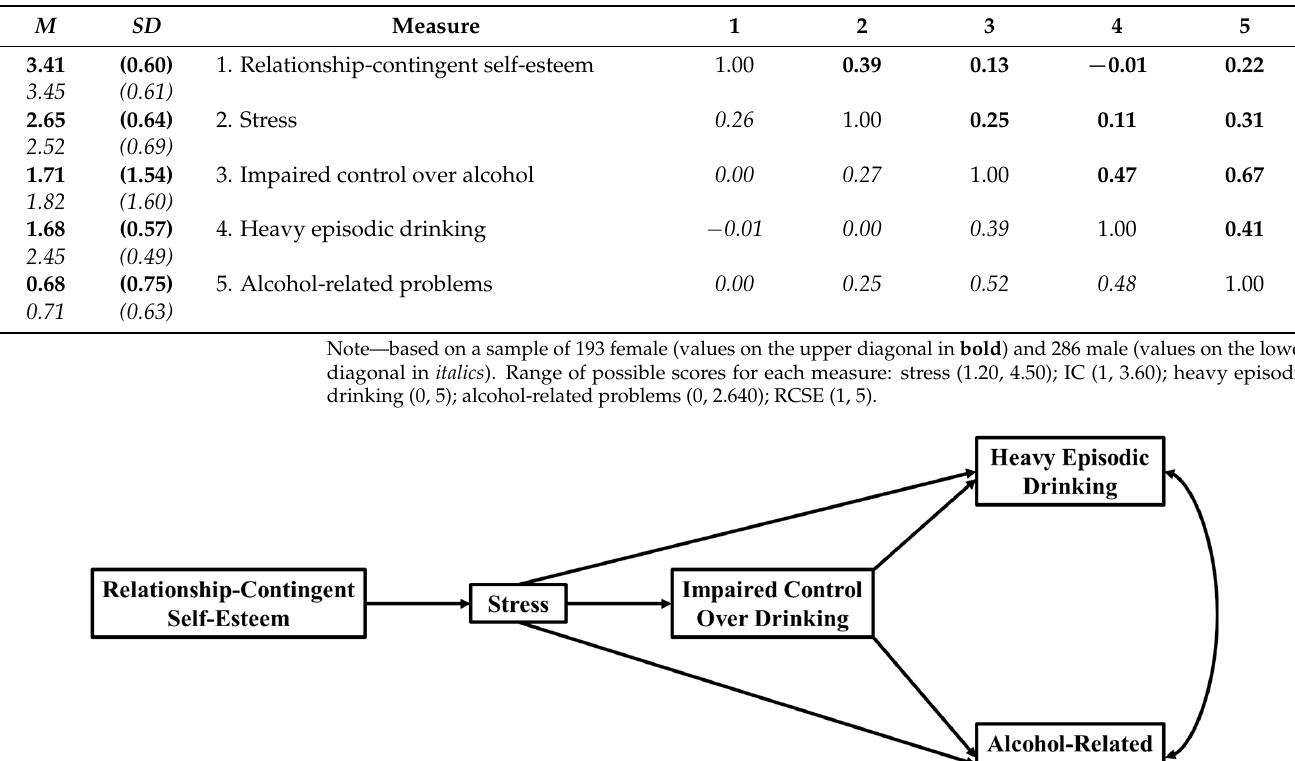
Table 2. Means, standard deviations, and correlations among all variables in the model.